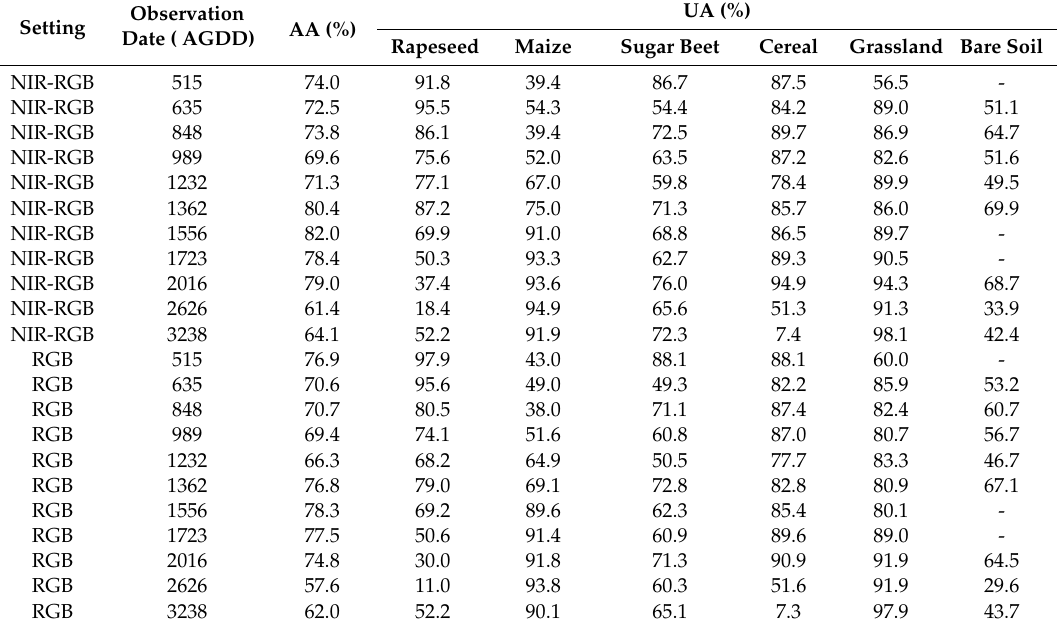
Table 3. Average accuracy (AA) and user accuracy (UA) for all settings and observation dates.